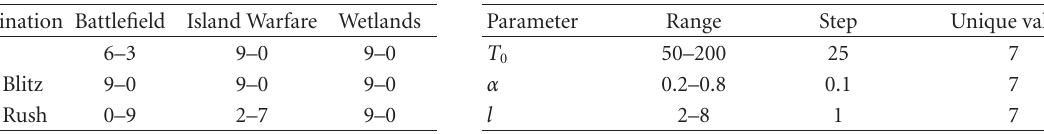
Table 1: Records for each agent combination on listed map (1st agent wins—2nd agent wins).